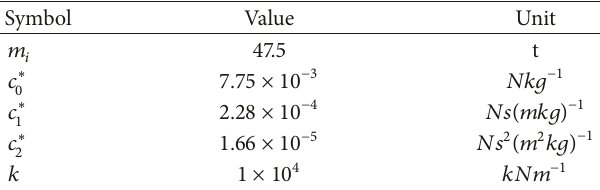
Table 1: Parameters of the CRH-3 high-speed train.